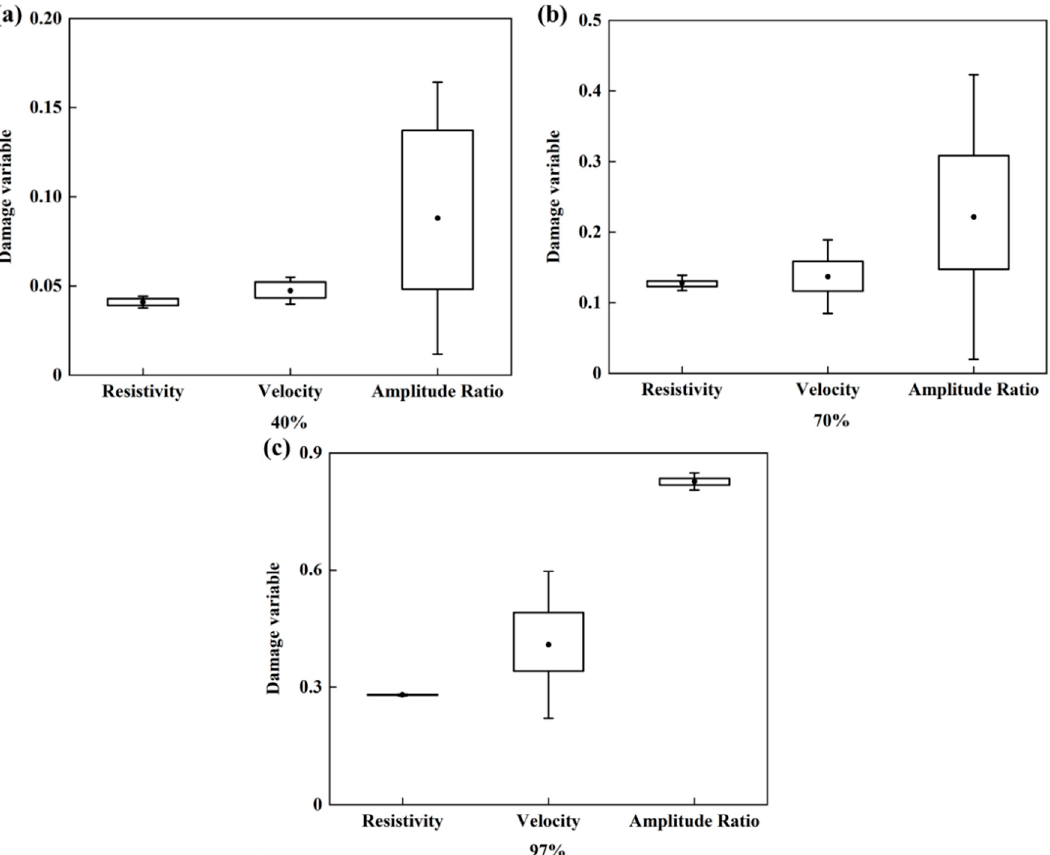
Figure 13. Stability of the damage variables derived from the NDT parameters. ( a – c ) correspond to three separate sandstone specimens for which the peak load reached 40%, 70% and 97% of the strength during cyclic loading,